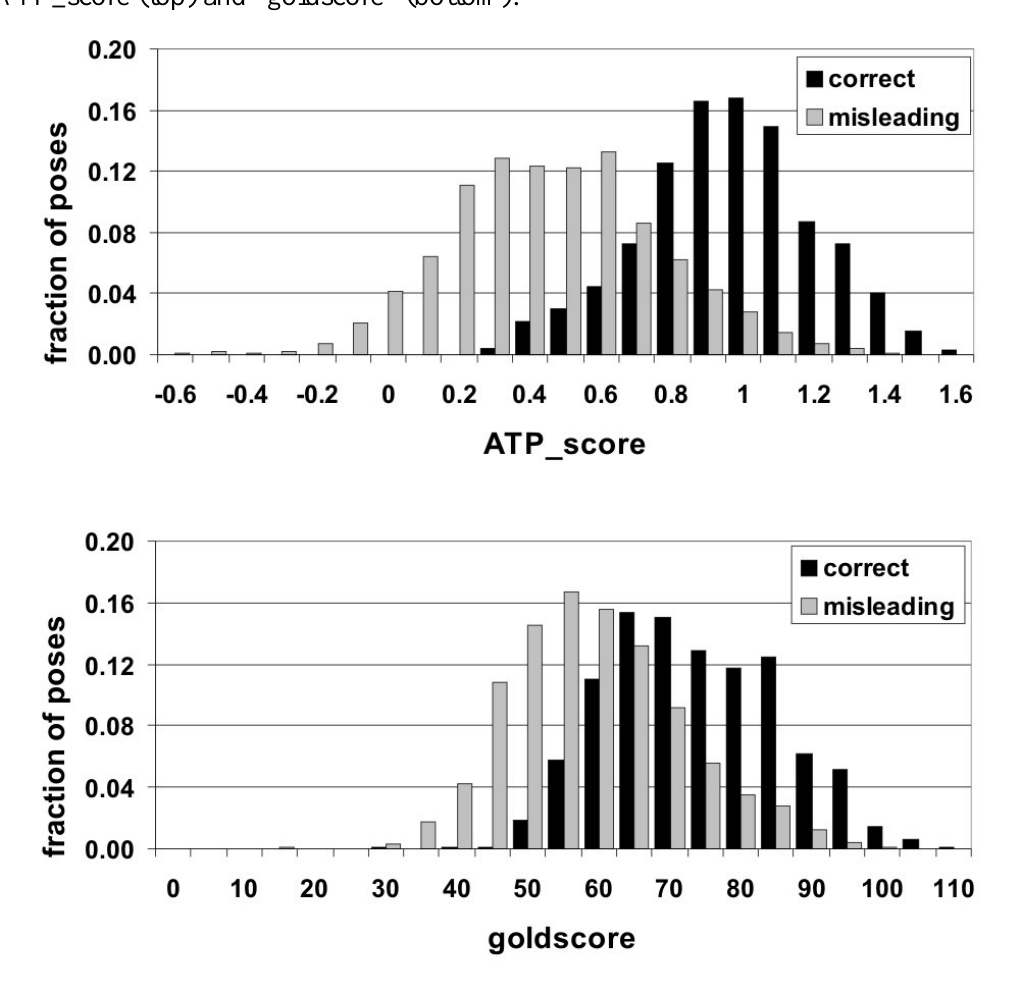
Figure 2. Distribution of correct and misleading ATP docking solutions over the values of ATP_score (top) and “goldscore”